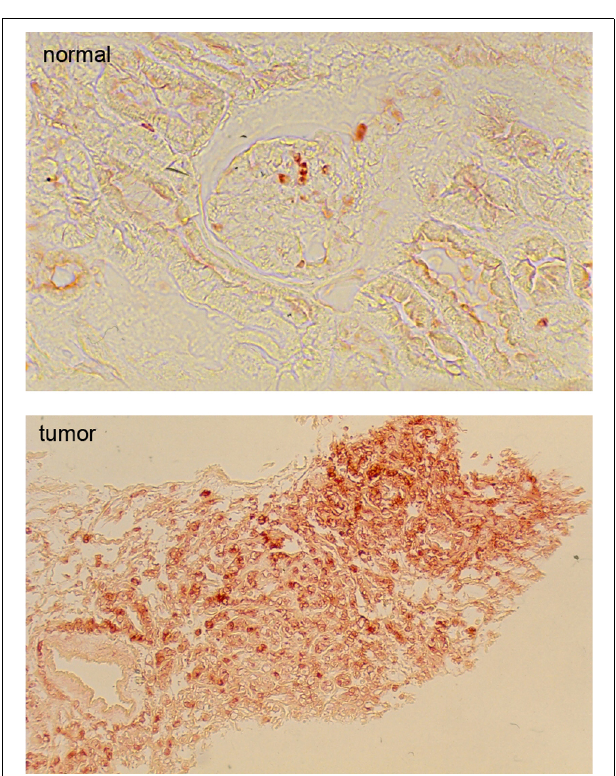
FIGURE 3 | Immunohistochemical detection of biliverdin reductase in normal human kidney cells and in a kidney tumor. Note that the magnification of the normal kidney is 10-fold greater than that of the tumor. Modified from (Maines et al., 1999).